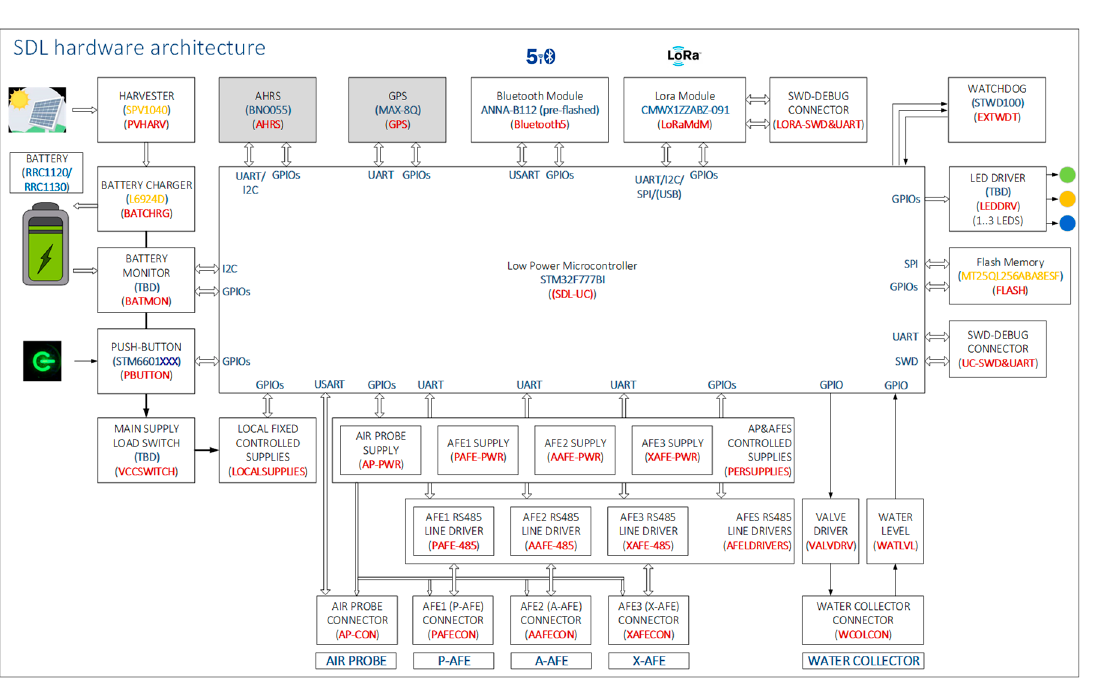
Figure 8. Smart Data Logger hardware block diagram .